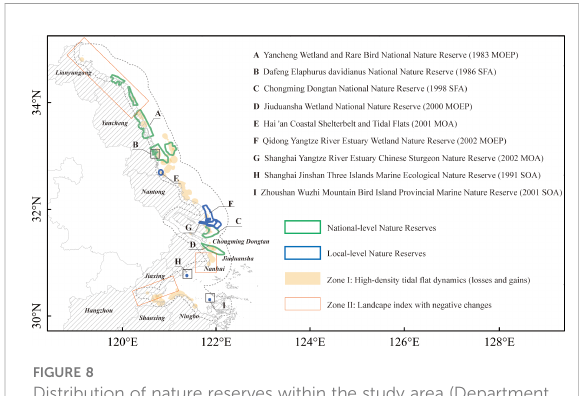
FIGURE 8 Distribution of nature reserves within the study area (Department of Nature Reserves at the local level: MOEP, Ministry of Environmental Protection; SOA, State Oceanic Administration; MOA, Ministry of Agriculture; SFA, State Forestry